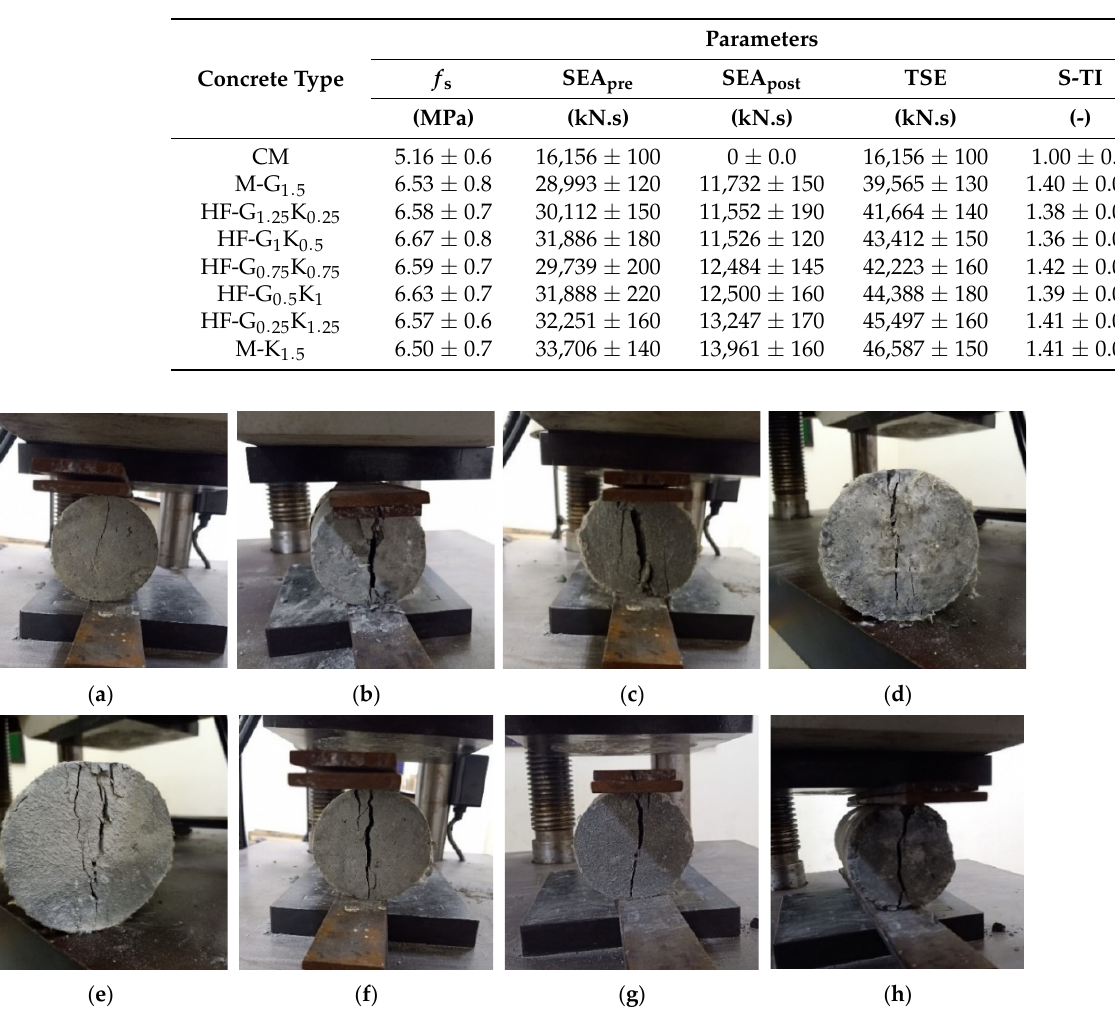
Table 10. Properties of concrete specimens under splitting tensile loading. Parameters f s SEA pre SEA post TSE S-TI Concrete Type (MPa) (kN.s) (kN.s) (kN.s)